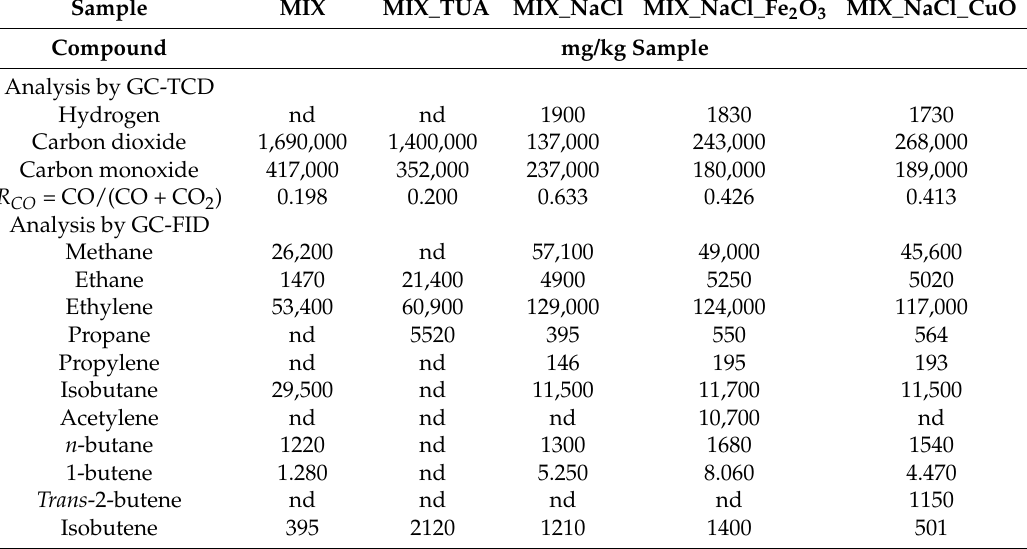
Table 2. Yield of gases and volatile compounds during the combustion experiments at 850 ◦ C ( λ = 0.5). Each run was duplicated ( n = 2) and average values are